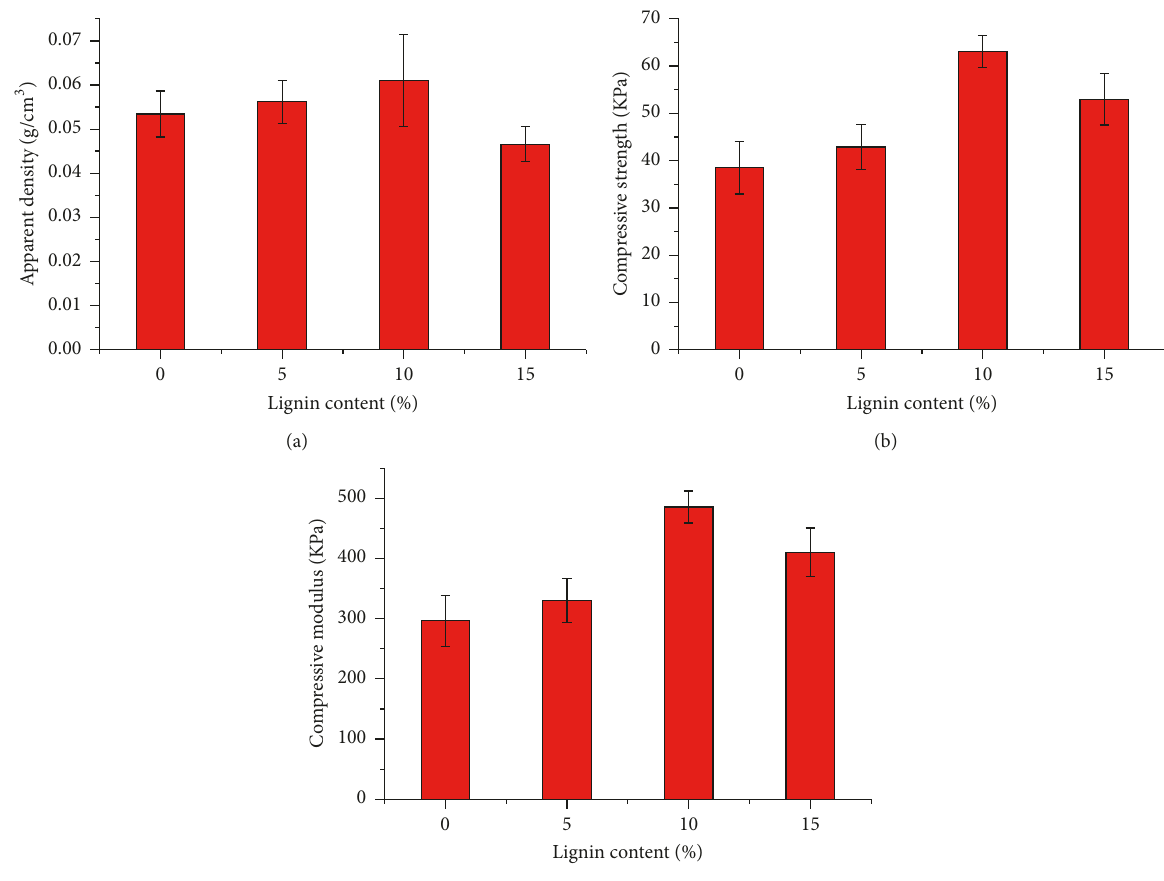
Figure 3: Effect of lignin content on (a) apparent density, (b) compressive strength, and (c) compressive modulus of the PU foams.